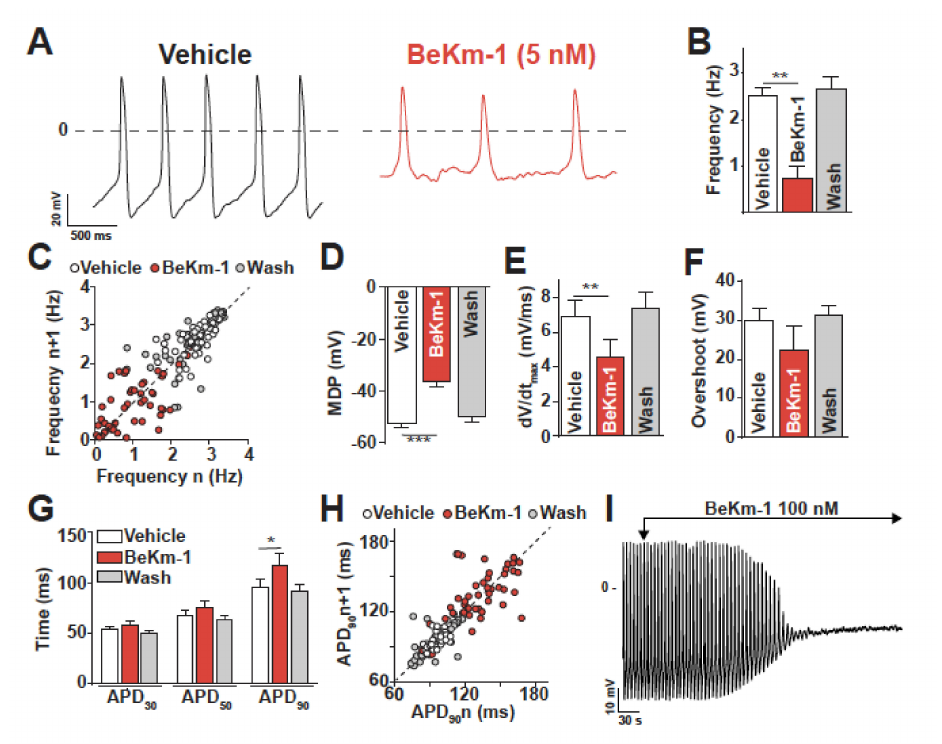
Figure 2. BeKm-1 alters spontaneous AP shape and frequency in human-induced pluripotent stem cell (hiPS-CMs). ( A ) Expanded traces from manual patch-clamp recordings showing the impact of 5 nM BeKm-1 on APs. ( B ) Average e ff ect of 5 nM BeKm-1 on AP frequency. ( C ) Poincar é plot showing changes in AP frequency variability from consecutive APs for vehicle, 5 nM BeKm-1, and wash conditions. ( D – F ) Average e ff ects of 5 nM BeKm-1 and reversibility of these e ff ects on maximum diastolic potential (MDP) (D), maximal upstroke velocity (dV / dt max ) (E) and overshoot (F). ( G ) E ff ect of 5 nM BeKm-1 and reversibility of this e ff ect on action potential durations (APDs) at 30%, 50% and 90% of repolarization. ( H ) Poincar é plot showing APD 90 variability from consecutive APs in vehicle, 5 nM BeKm-1, and wash conditions. Note the presence of red BeKm-1-associated dots underneath the cluster of white vehicles representing dots. ( I ) Representative trace showing AP arrest on a cell treated with 100 nM BeKm-1. All parameters were analyzed on ventricular-like cardiomyocytes only, as determined by objective AP shape characteristics. Thus, atrial-like and nodal-like cells were excluded from the analysis. Vehicle n = 7; 5 nM BeKm-1 n = 7; wash n = 5. Paired t-test: *, p < 0.05; **, p <